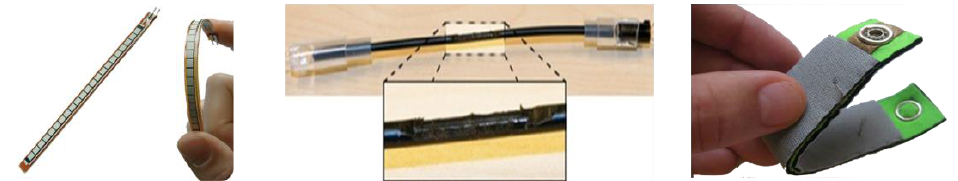
Figure 1. Types of flex sensors (from left, conductive ink, fiber-optic, and conductive fabric based). Sensors made with an optical fiber support high accuracy and high durability. How- ever, a pair of a light source and a detector is required, and only unidirectional sensing is possible [24]. Conductive fabric/polymers can be used for wearable applications due to